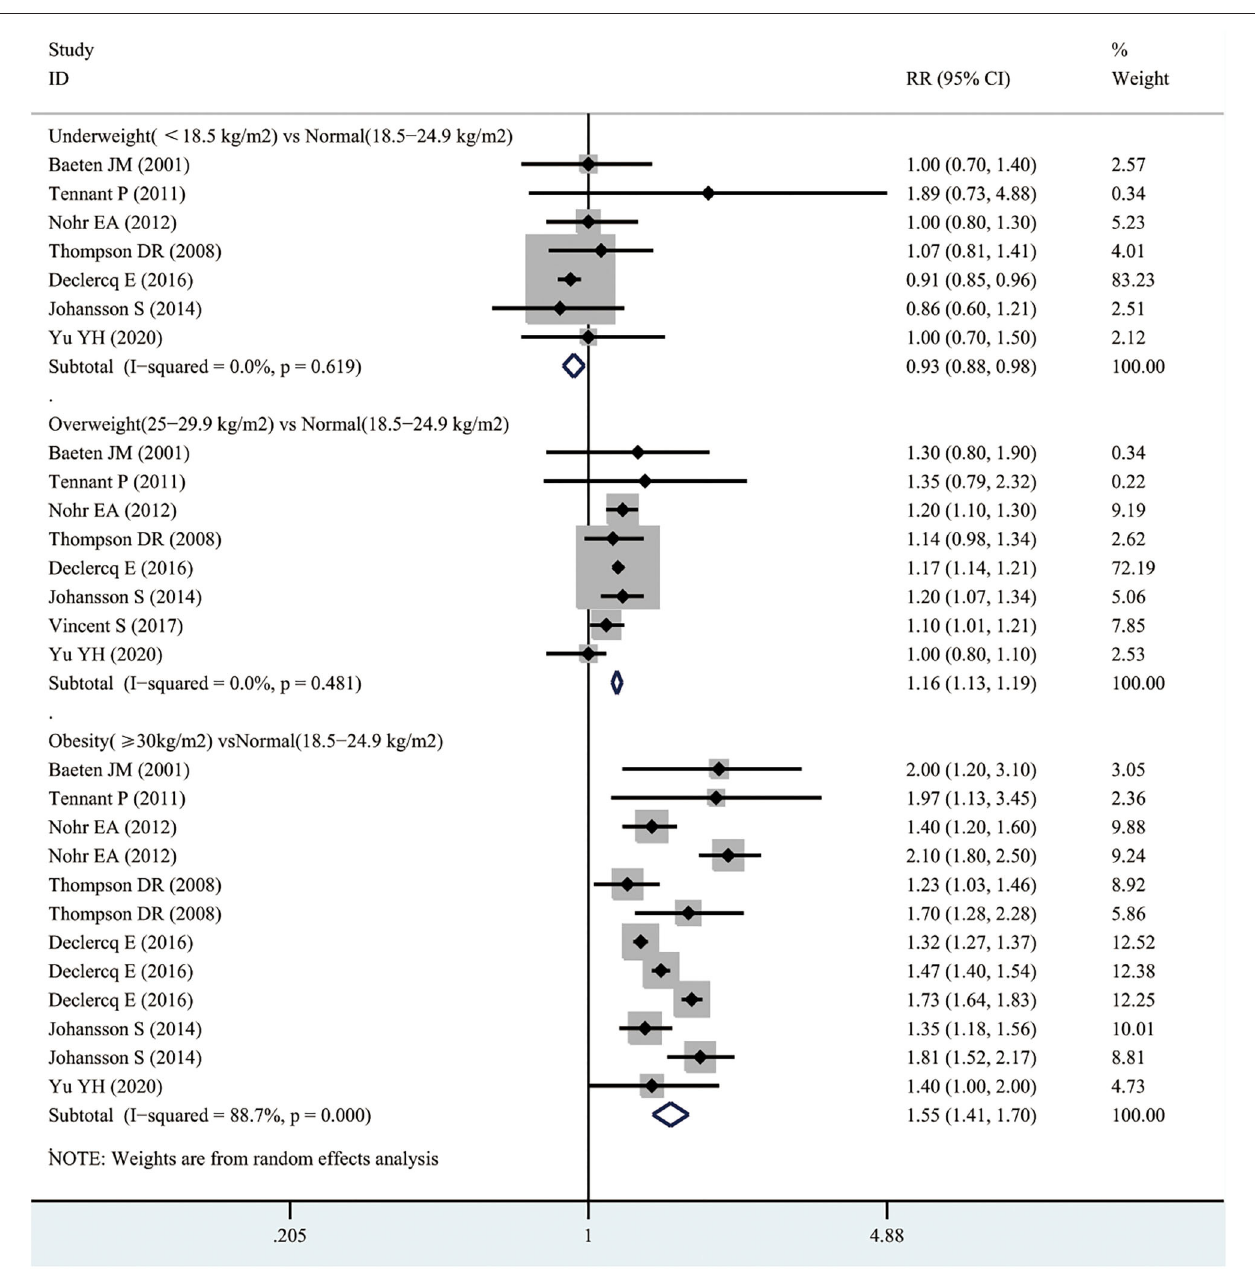
FIGURE 2 | Forest plots of maternal BMI and the risk of infant